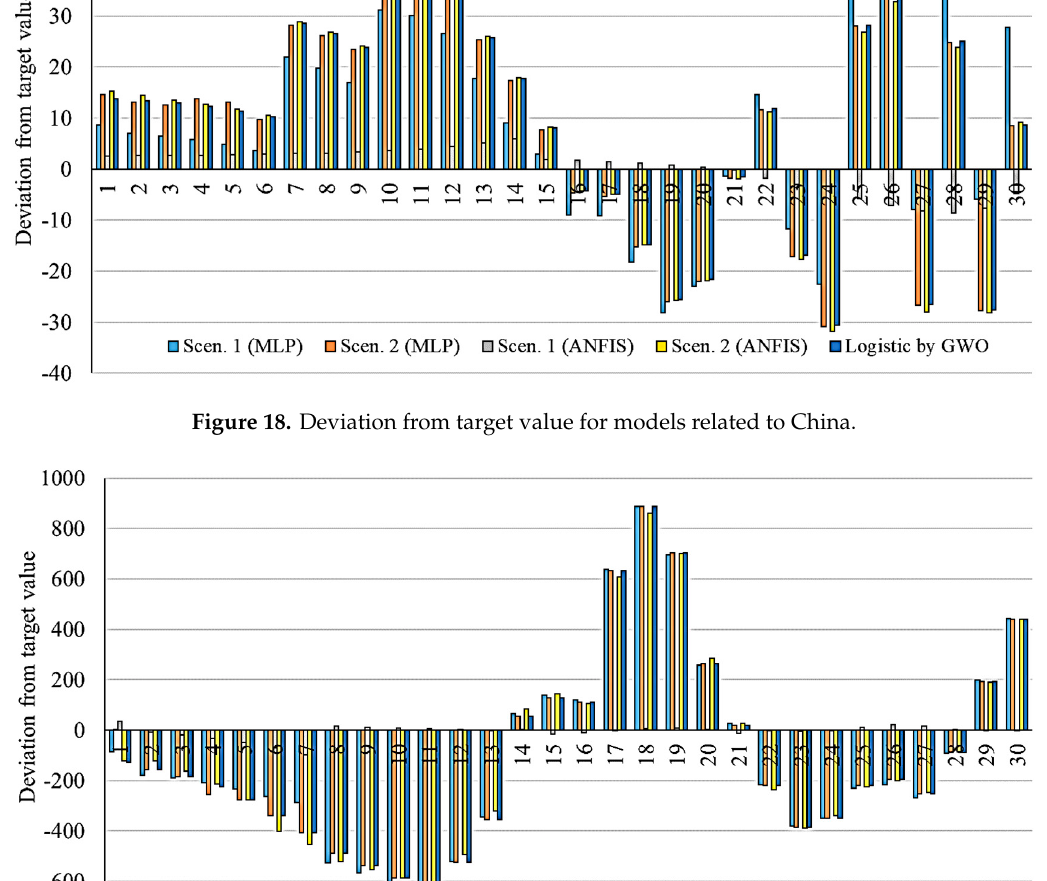
Figure 17. Deviation from target value for models related to Italy.